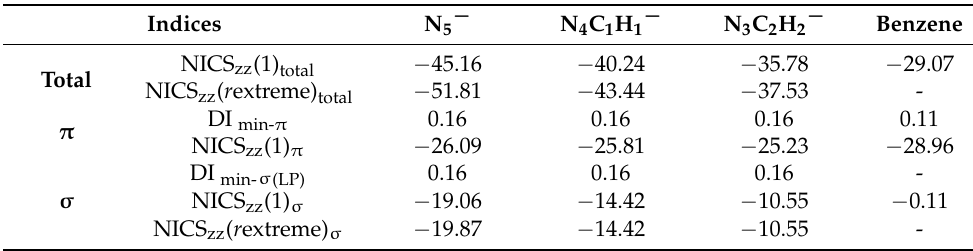
Table 1. Magnetic index of aromaticity and electron delocalization index of N 5 ¯ , N 4 C 1 H 1 ¯ and